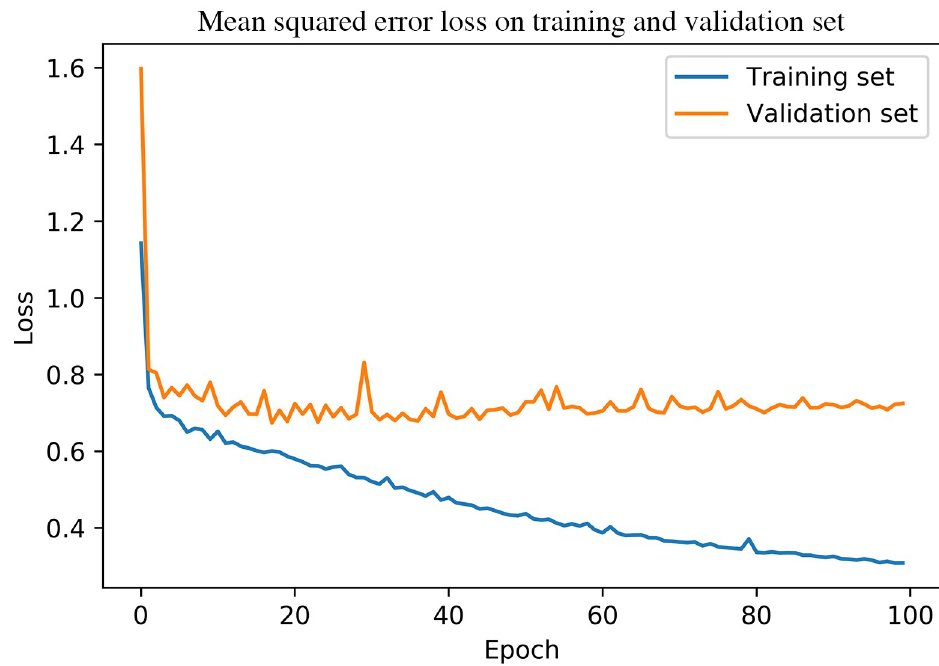
Fig 4. Convergence of validation loss after 15 epochs for a ConvLSTM based model.